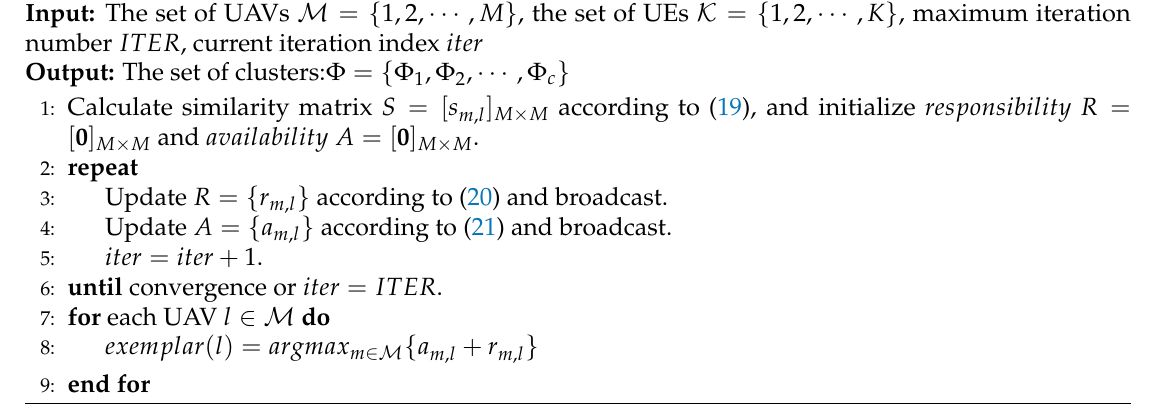
Algorithm 2 Affinity-Propagation clustering for UAV-assisted network